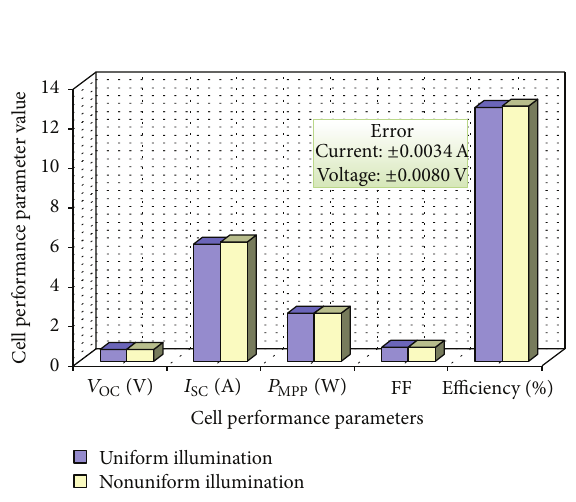
Figure 4: Comparison of various PV cell performance parameters ( 𝑉 OC , 𝐼 SC , 𝑃 MPP ,FF,and 𝜂 )foruniformandnonuniformillumination profiles at low energy concentration. The level of nonuniform illumination was 25% of the total cell